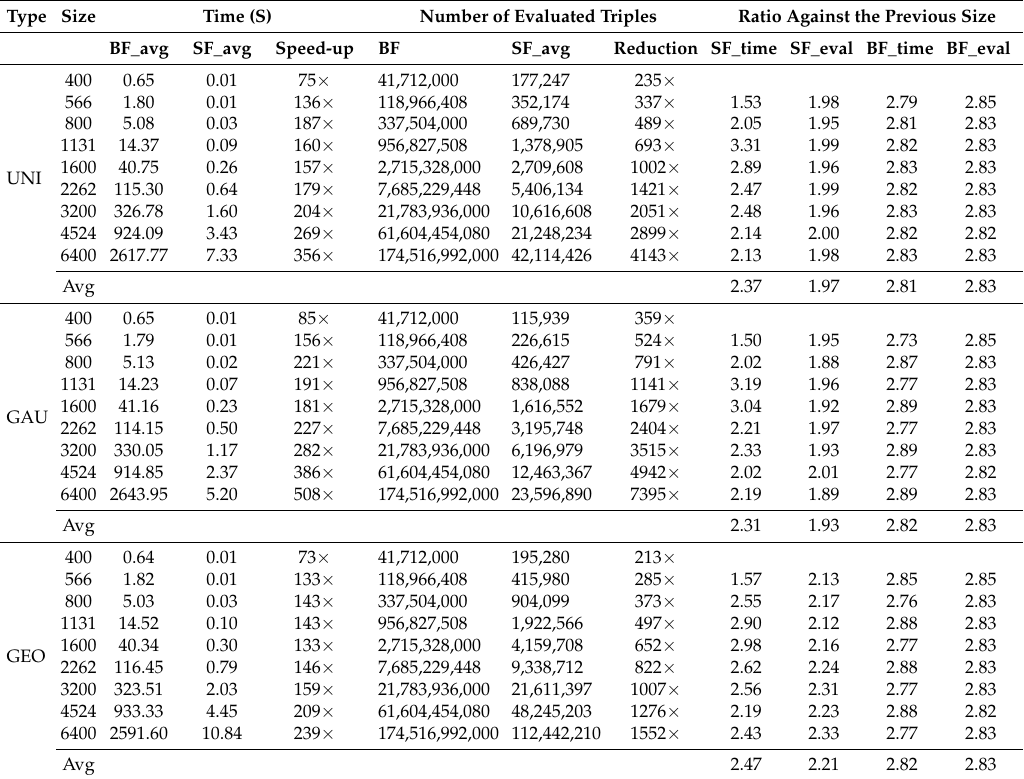
Table 3. Comparing smart force (SF) and brute force (BF) in finding one Best Improving move starting from a random tour and using pure 3-OPT moves only (averaged over 1000 attempts).